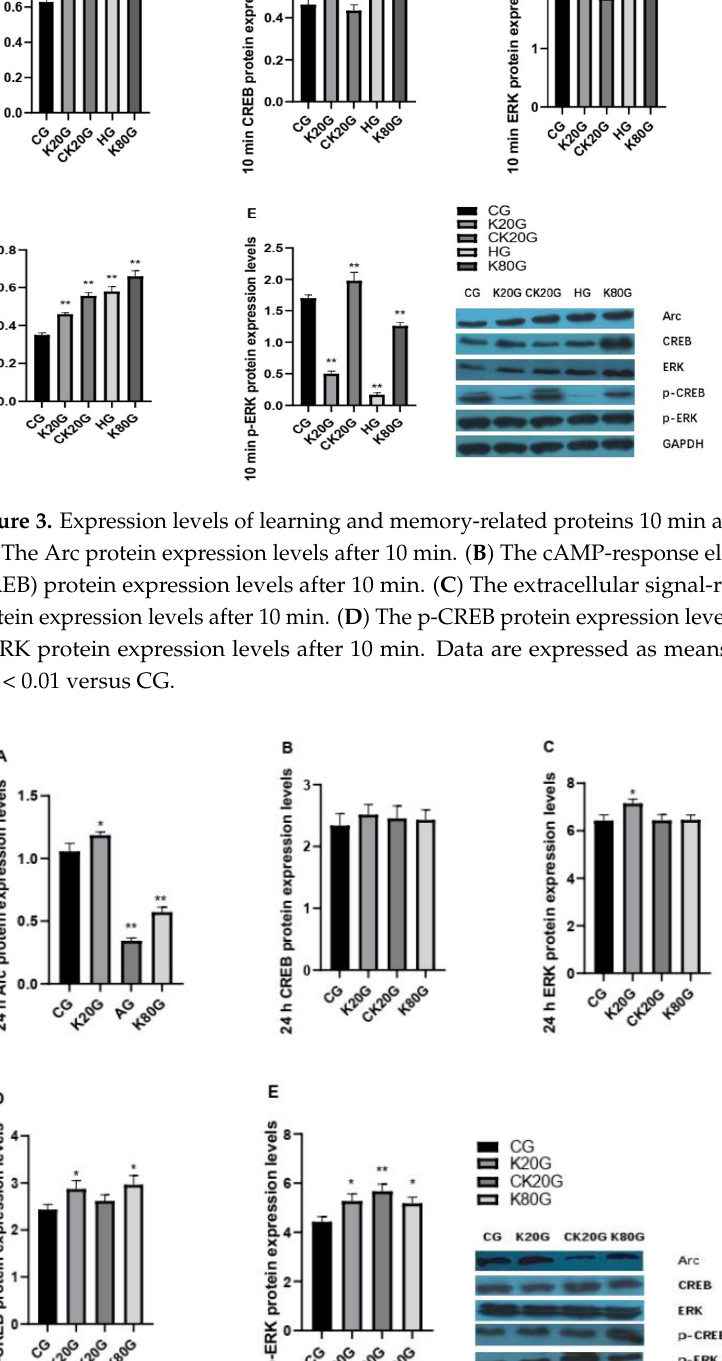
Figure 4. Expression levels of learning and memory-related proteins 24 h after ketamine injection. ( A ) The Arc protein expression levels after 24 h. ( B ) The CREB protein expression levels after 24 h. ( C ) The ERK protein expression levels after 24 h. ( D ) The p-CREB protein expression levels after 24 h. ( E ) The p-ERK protein expression levels after 24 h. Data are expressed as means ± SD. * p < 0.05 and ** p < 0.01 versus